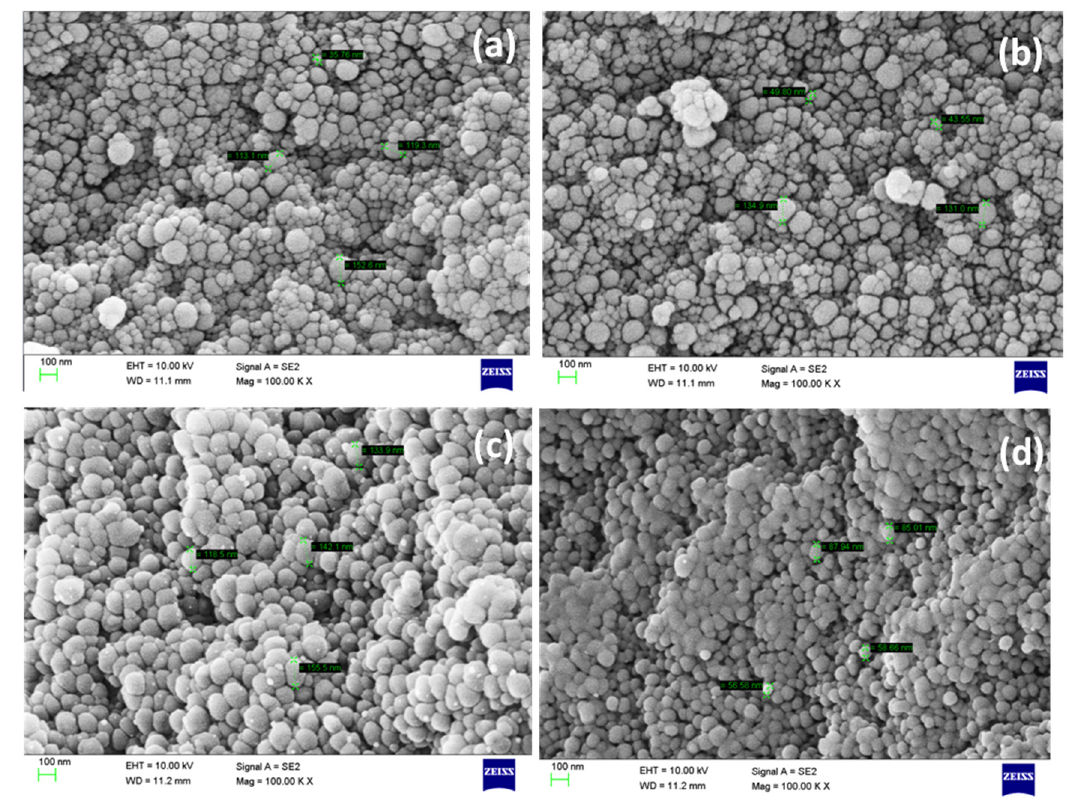
Figure 7. SEM images of ( a ) BRD 132 , ( b ) BRD 141 , ( c ) BVD 132 , and ( d ) BVD 141 fluorescent dispersions.